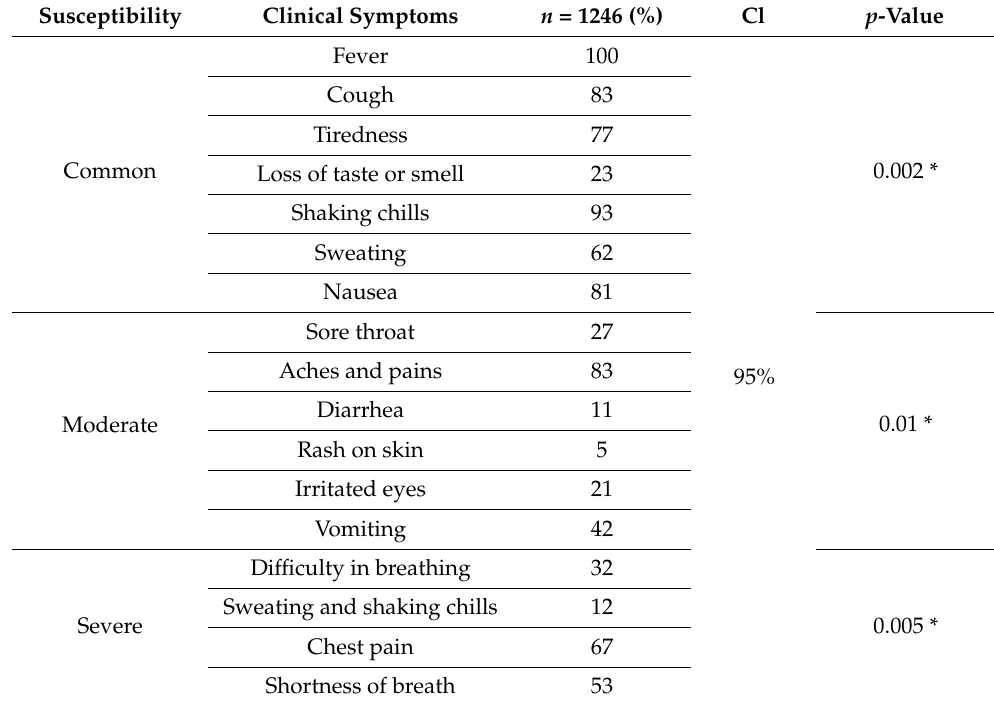
Table 5. Clinical observations of patients with negative COVID-19 PCR tests.